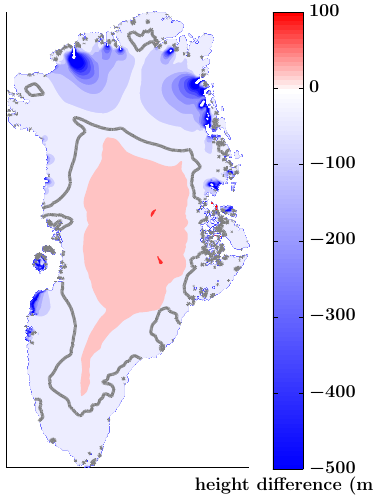
equilibrium simulation preindustrial states: blue colors indicate that the transient spin-up state is lower, while red colors indicate that the transient spin-up state is higher. The thick grey line is the zero-